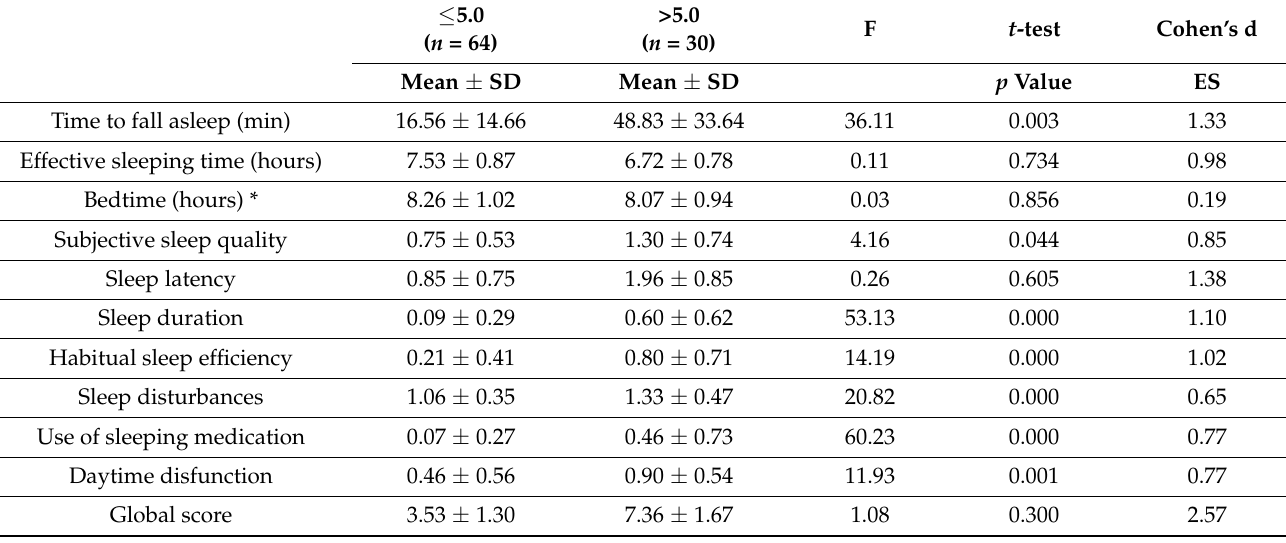
Table 3. Comparison between male professional soccer players with scores ≤ 5.0 and above five on the Pittsburgh questionnaire.